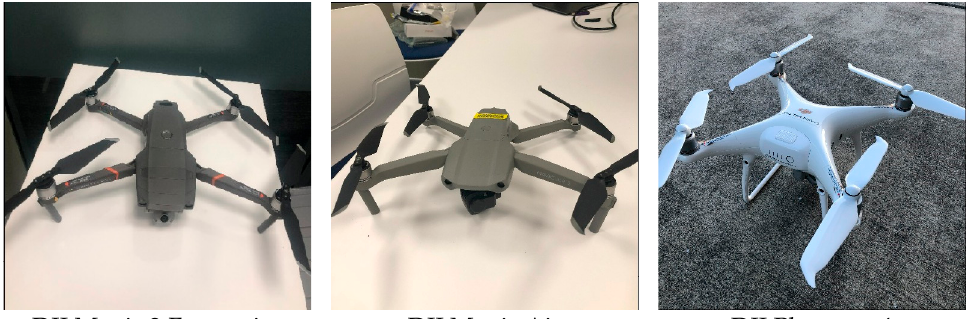
Figure 1. UAVs Employed in Current Study.